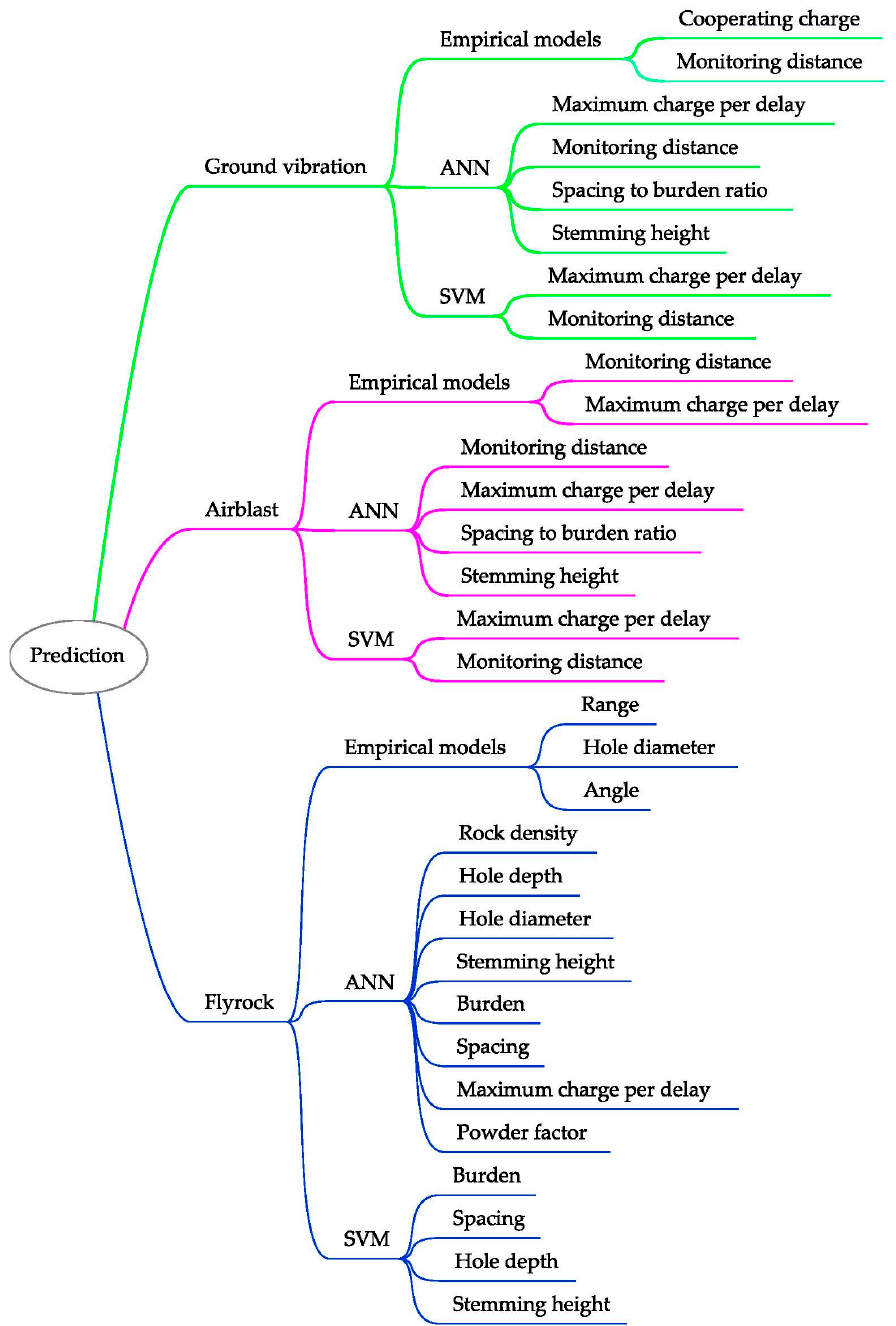
Figure 10. Predominate parameters for predicting blast impacts.